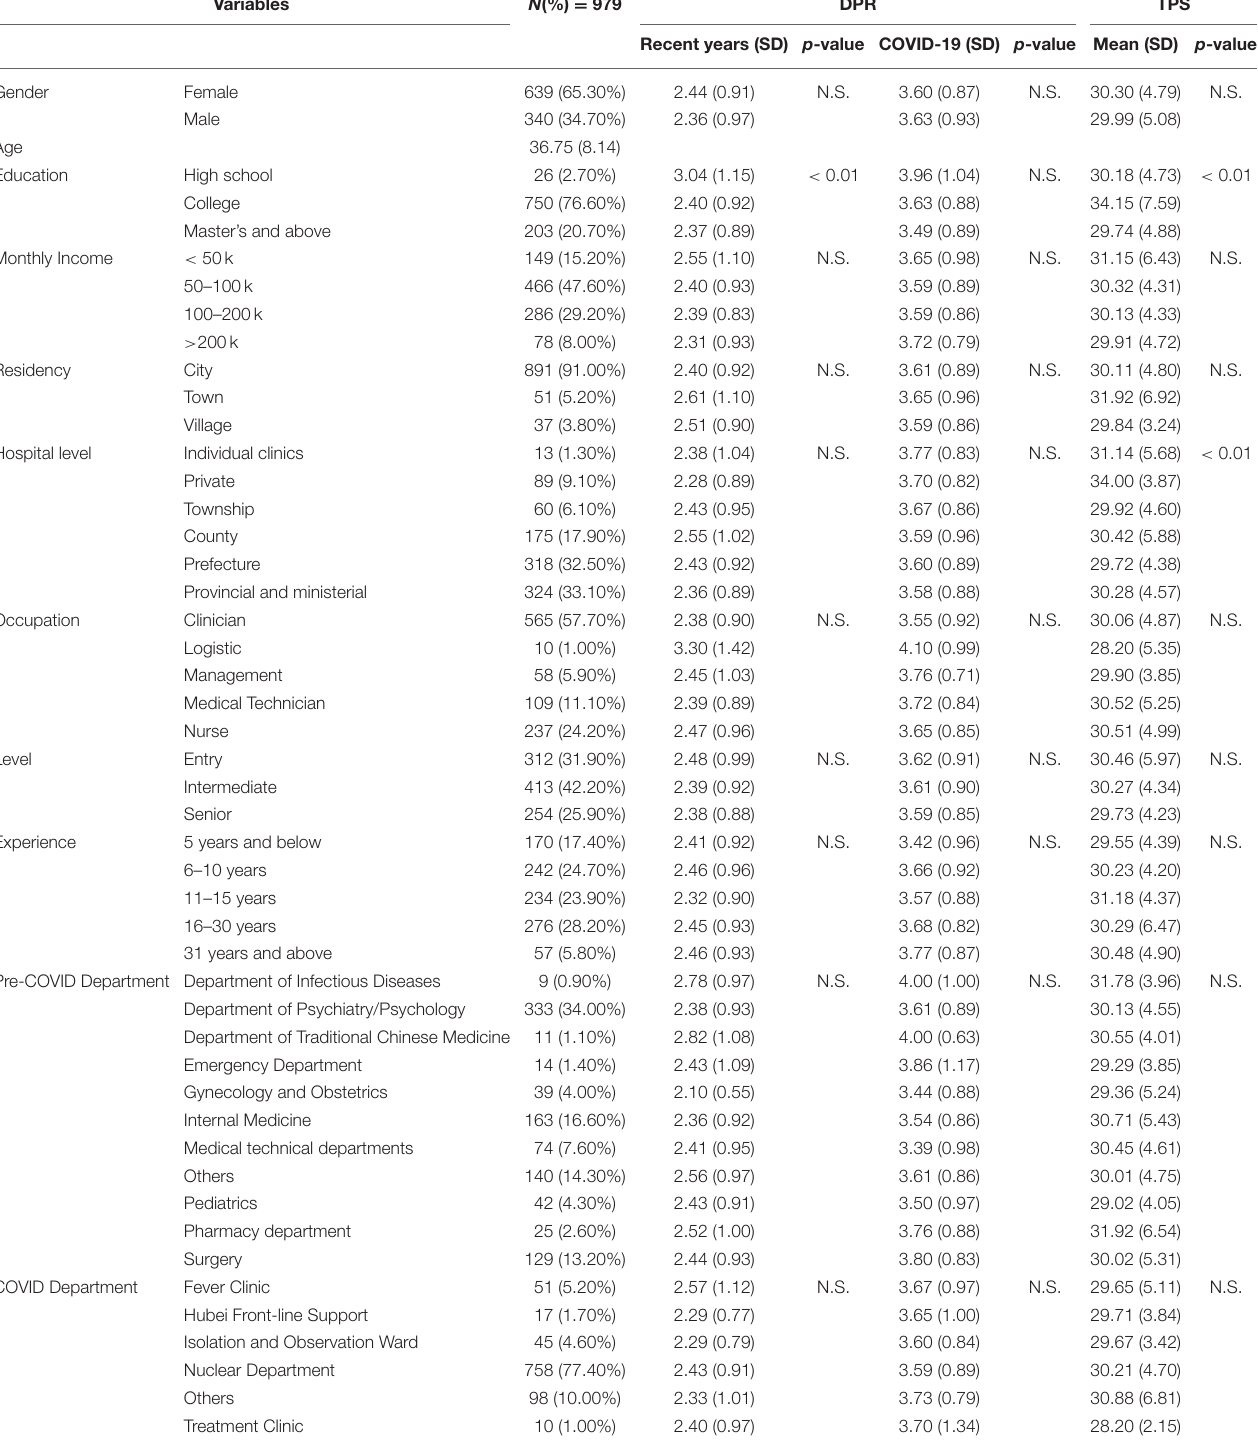
TABLE 1 | Demographic characteristics and variables of doctor-patient relationship.